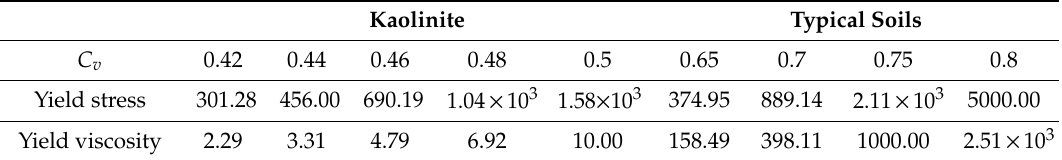
Table 3. The yield stress and yield viscosity of kaolinite and typical soils.